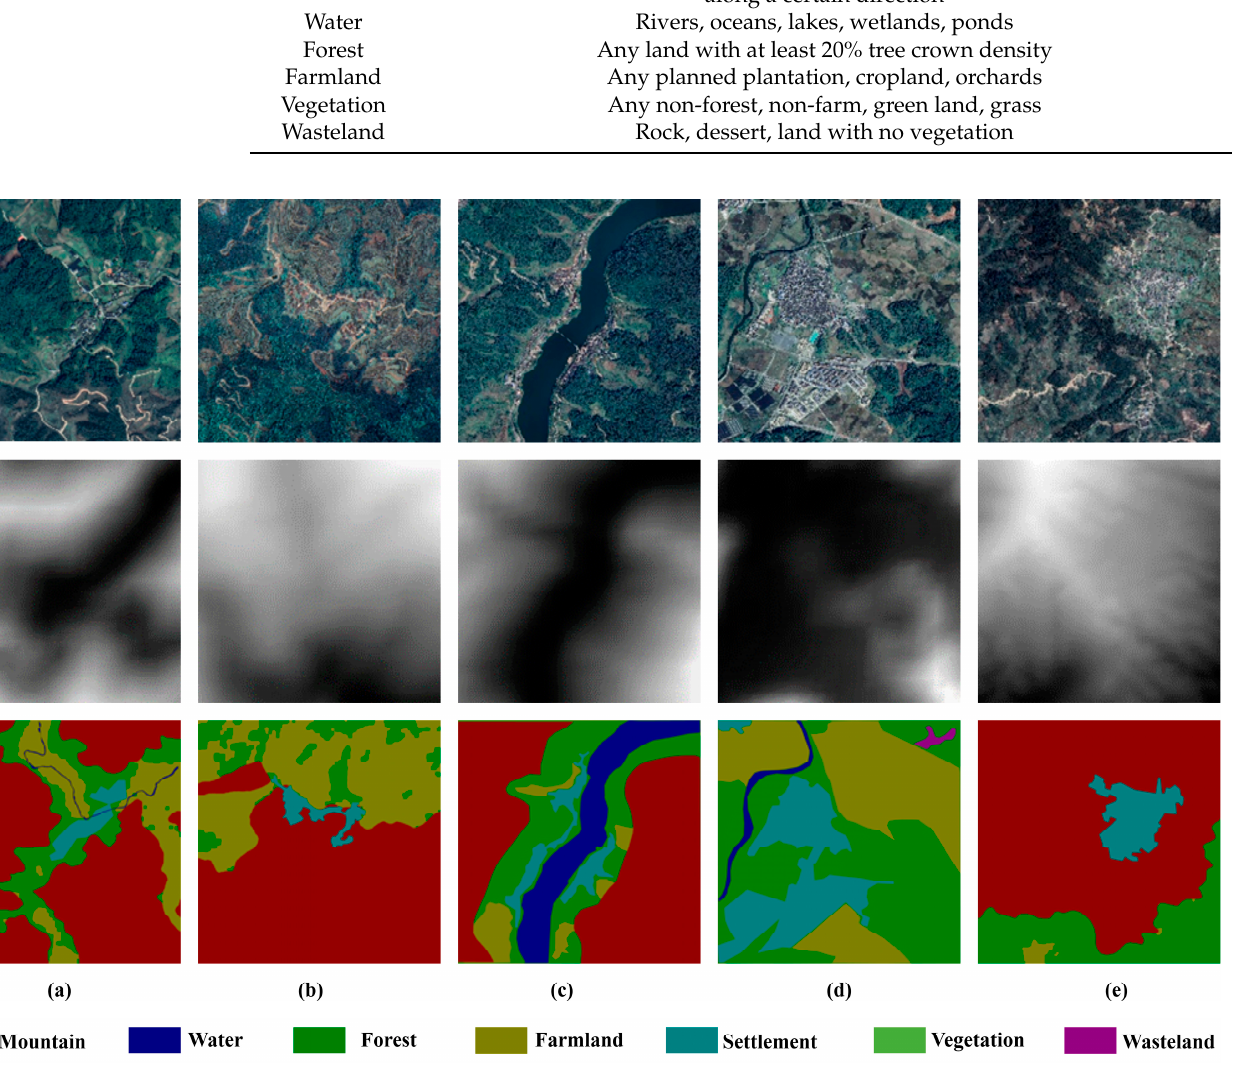
Figure 4. Some examples of pairs of remote sensing images ( top ), DEM data ( middle ), and settlement environment maps ( bottom ) belong to the following five environmental patterns: ( a ) river valley; ( b ) foothill; ( c ) riverine; ( d ) plain; ( e ) hillside. Table 3. Splitting the TCS environmental pattern